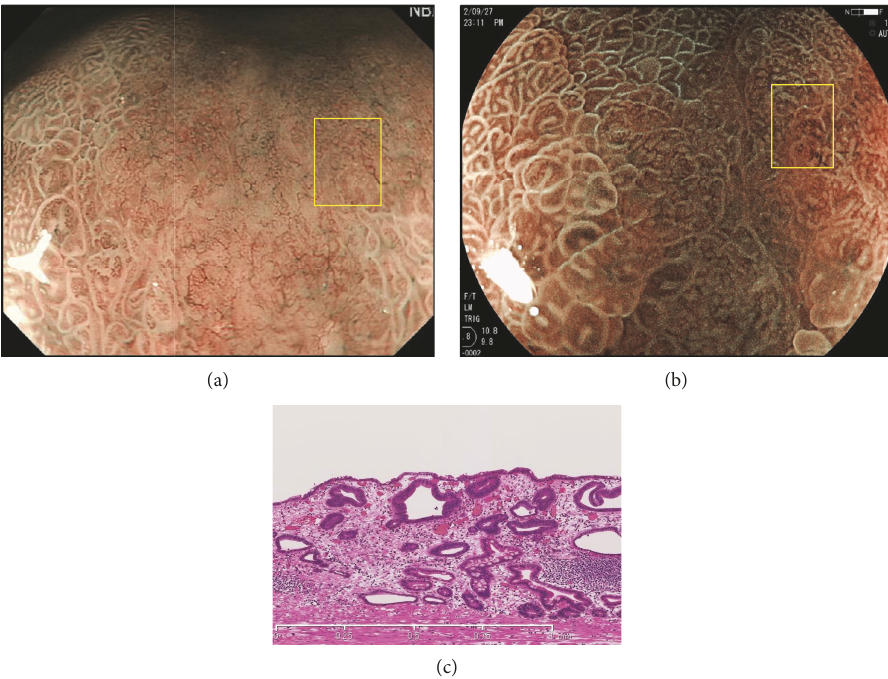
Figure 3: A well-di ff erentiated adenocarcinoma in group A. (a) MSP was absent on ME-NBI (yellow box). (b) ME-BLI showed an irregular MSP (yellow box). (c) Histological view of the yellow box in Figures 3(a) and 3(b). There was a small number of crypt openings in the surface